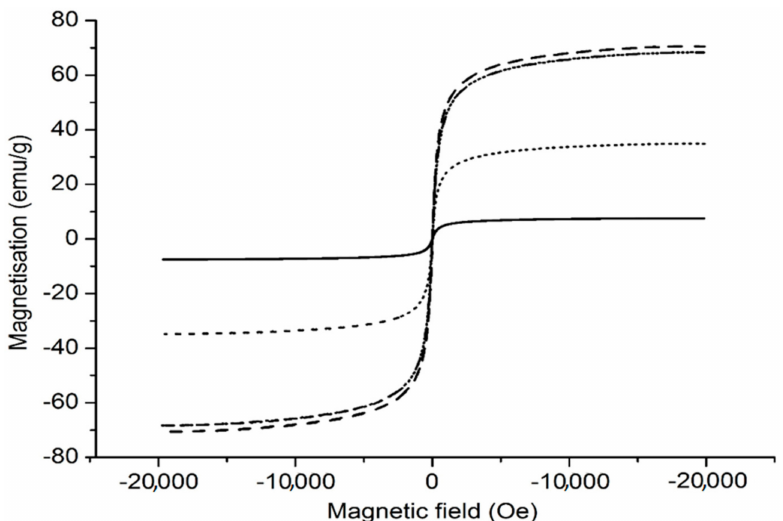
Figure 6. Magnetisation loops for magnetic nanoparticles (MNPs) (dash); MPEI (dash dot); physical mixture of MPEI and CePEI (dot); and MCePEI-GA